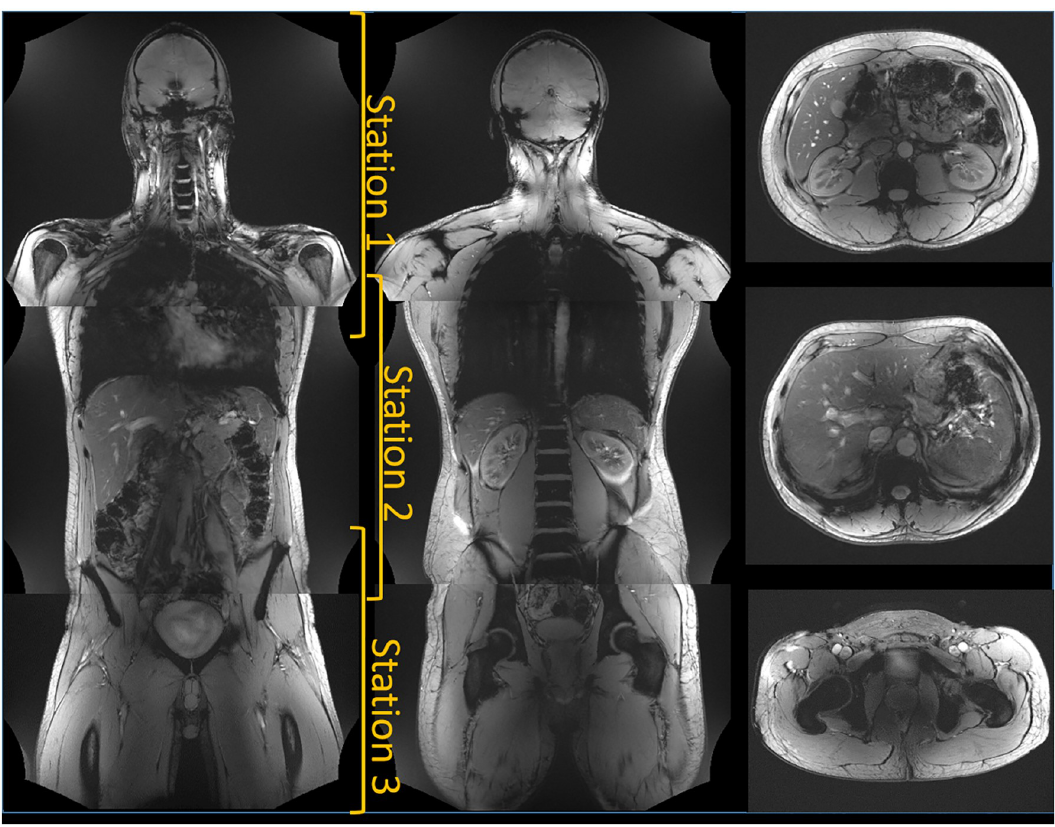
Fig 9. In-vivo images of a large volunteer using TIAMO. Three overlapping stations of 50 cm were acquired. The left images show coronal views, the three images on the right show transverse views of the same volunteer. All images were acquired with the body coil in Tx/Rx